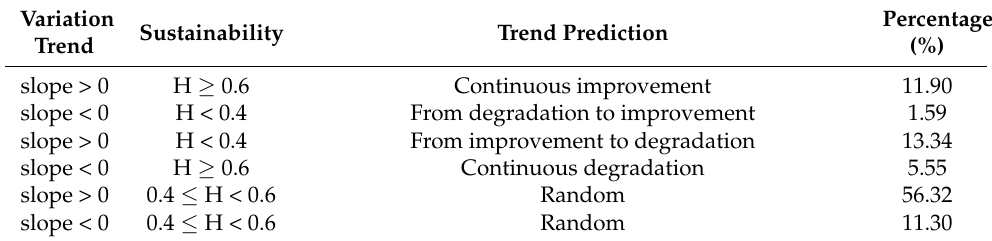
Table 3. Statistics of sustainability prediction results of NDVI variation trend in Anhui